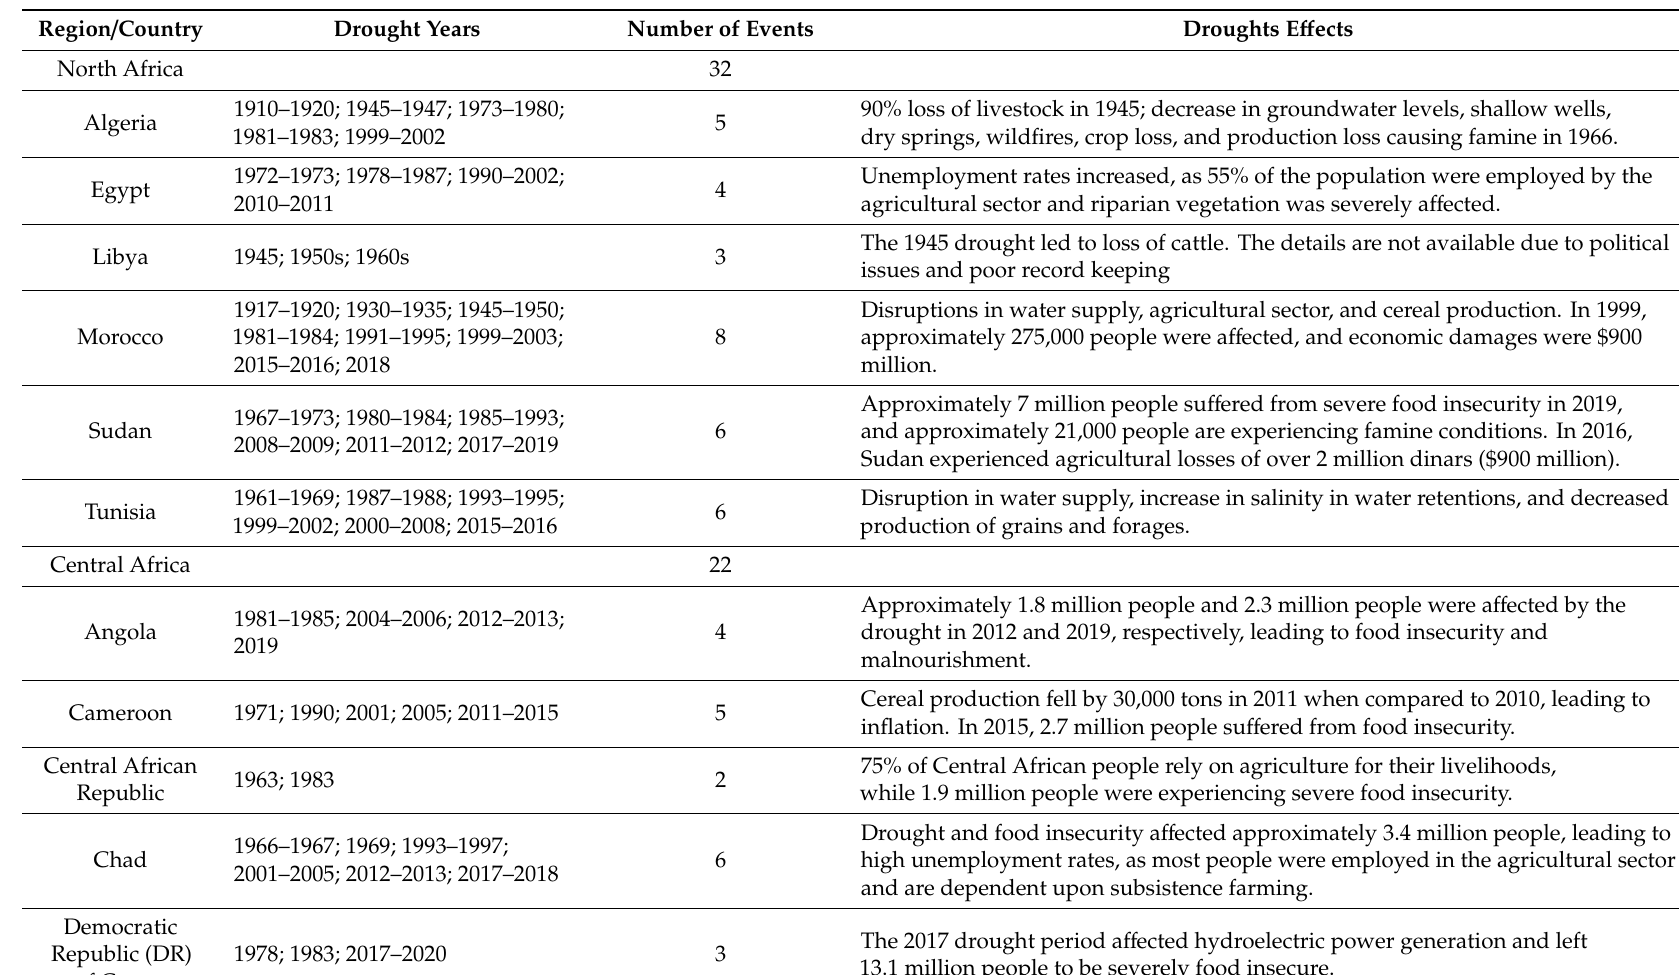
Table 1. Occurrence and impacts of major recorded droughts in Africa from the 1900s. No data available for Equatorial Guinea, Gabon, and Sierra